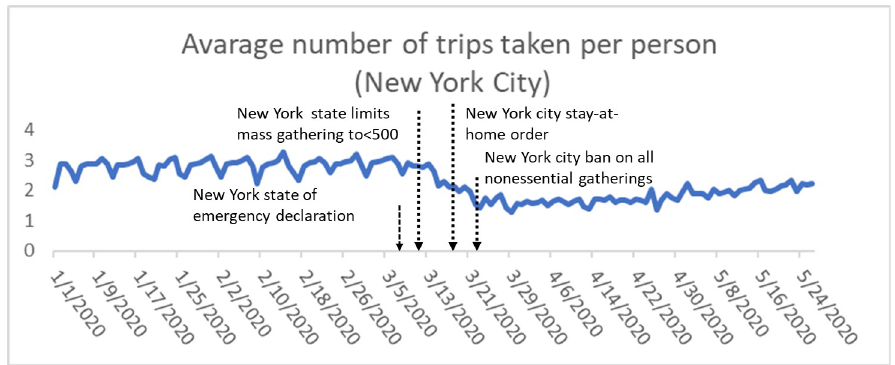
Fig 1. Average number of trips taken per person in New York City during January 1, 2020 and May 24, 2020.